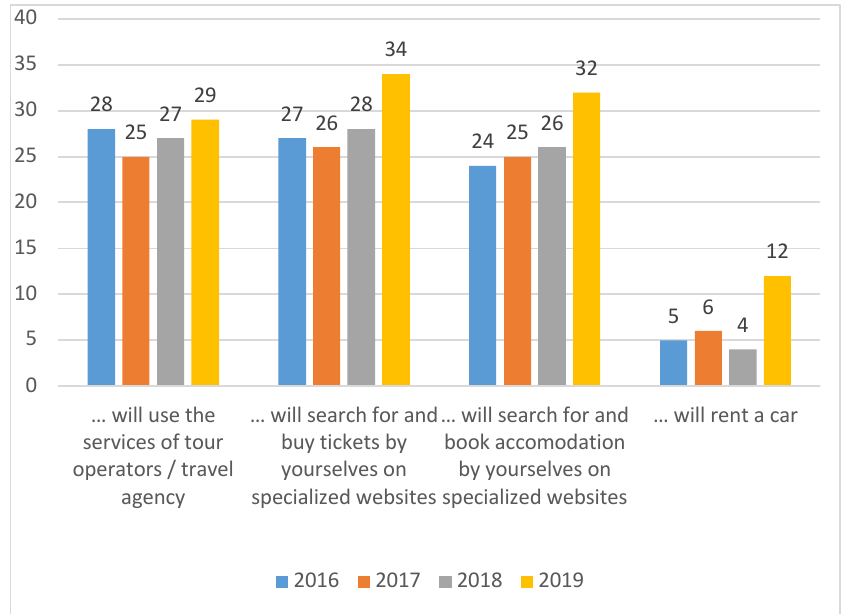
Fig. 2. The results of respondents' answers by